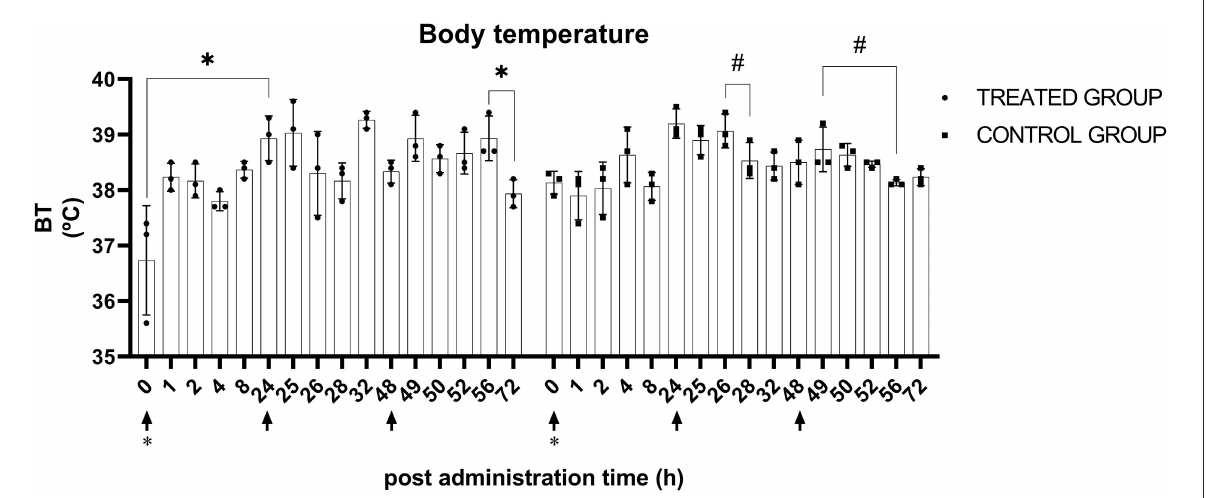
FIGURE3 Body temperature after KMRC011 or normal saline administration. KMRC011 was administered (solid arrows) at 0, 24, and 48h after irradiation (asterisk). Body temperature showed significant changes in both control and treated groups after the administration. However, there was no consistency and none of the animals showed actual hyperthermia. * p < 0.05; # p < 0.05, largest difference without statistical significance in the post-hoc